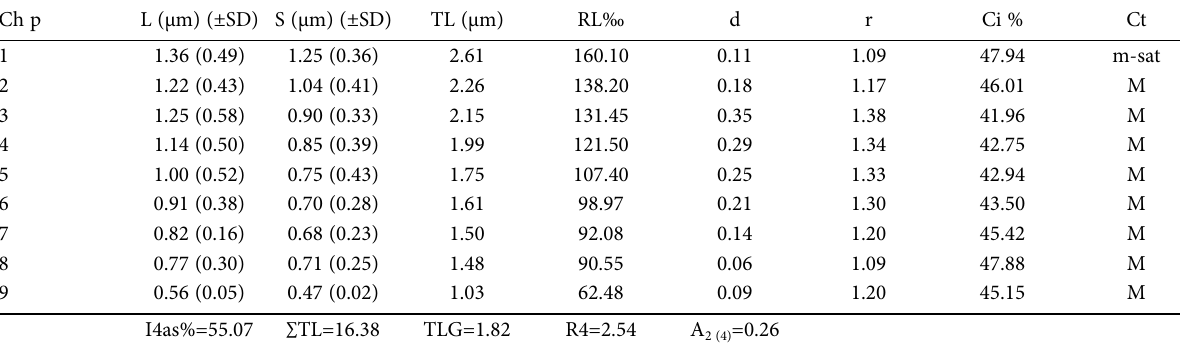
Table 5. Morphometric data within the population 26/10 (2n=18) of Trifolium subterraneum L. in Algeria. Ch p